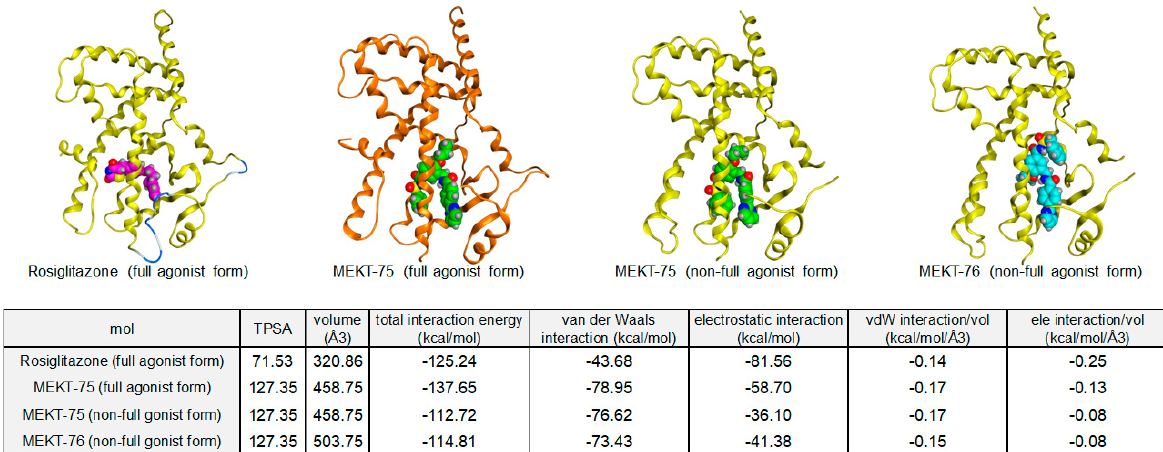
Figure 4. The binding energy comparison between hPPAR γ ligands complexed with hPPAR γ LBD. ( Up ) Monomeric structures of the hPPAR γ LBD ligand. ( Down ) Summary of the binding energy calculations of rosiglitazone, MEKT ‐ 75, and MEKT ‐ 76 complexed with hPPAR γ LBD.